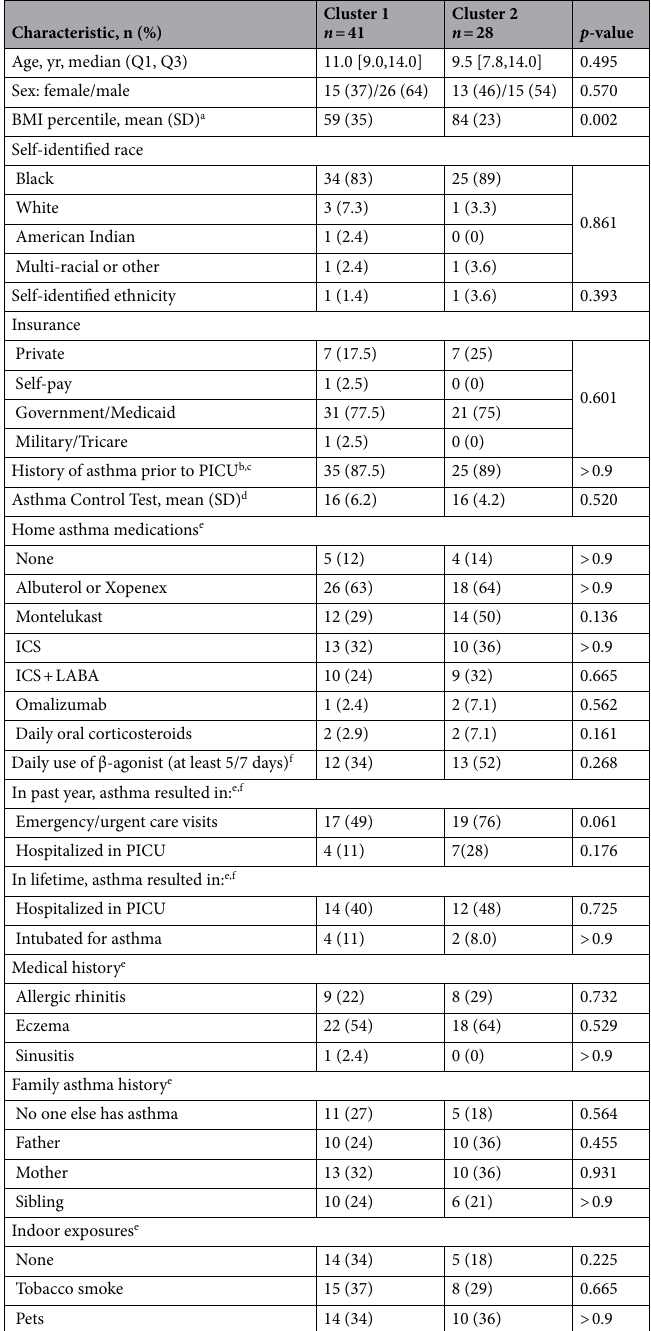
Table 1. Demographics and asthma history of the participants by cluster. a Ten missing in Cluster 1, 2 in Cluster 2, b Pediatric intensive care unit; c One Missing in Cluster 1; d 7 missing in Cluster 1, 6 in Cluster 2; e More than one condition can be selected, and frequency total may add up to more than 100%; f Six missing in Cluster 1, 3 in Cluster